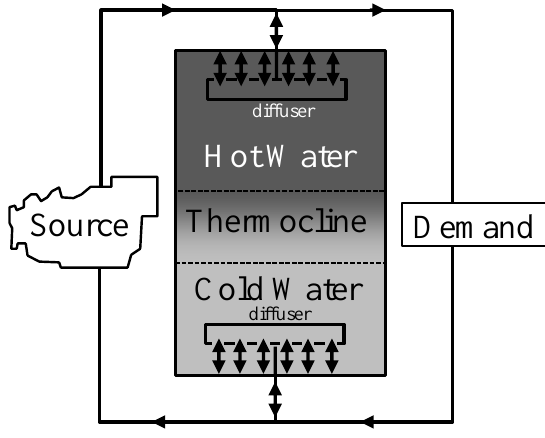
Figure 1. Connection scheme of a thermal energy storage